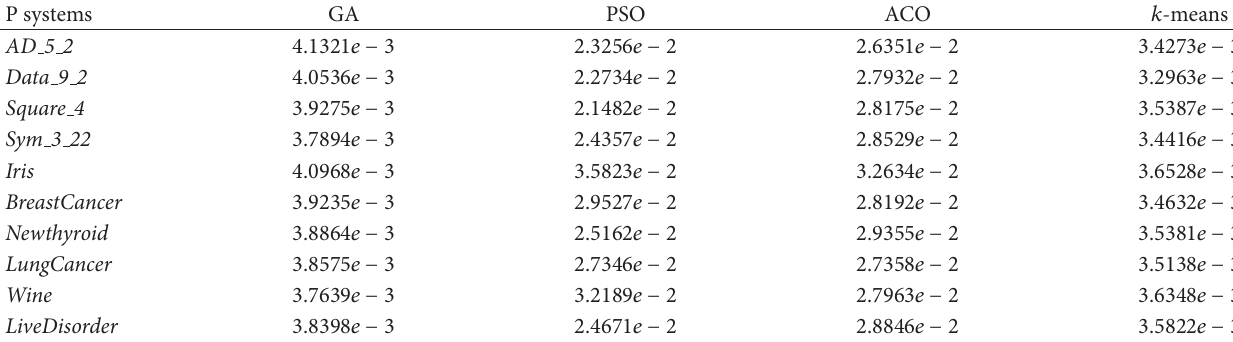
Table 4: The results of 𝑃 values produced by Wilcoxon’s rank sum test. P